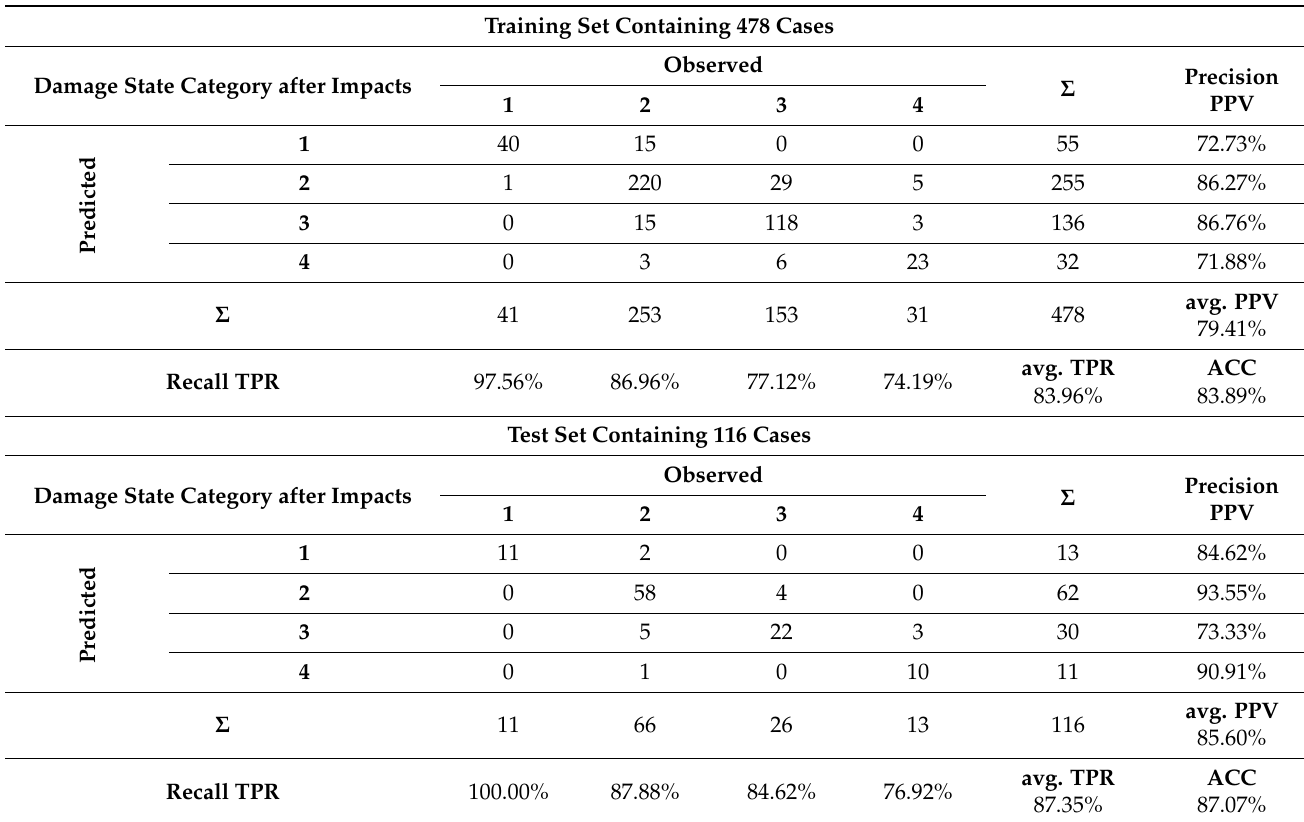
Table 6. Confusion matrix for the BBN classifier—accuracy of classification, average precision and average recall for training and test sets.